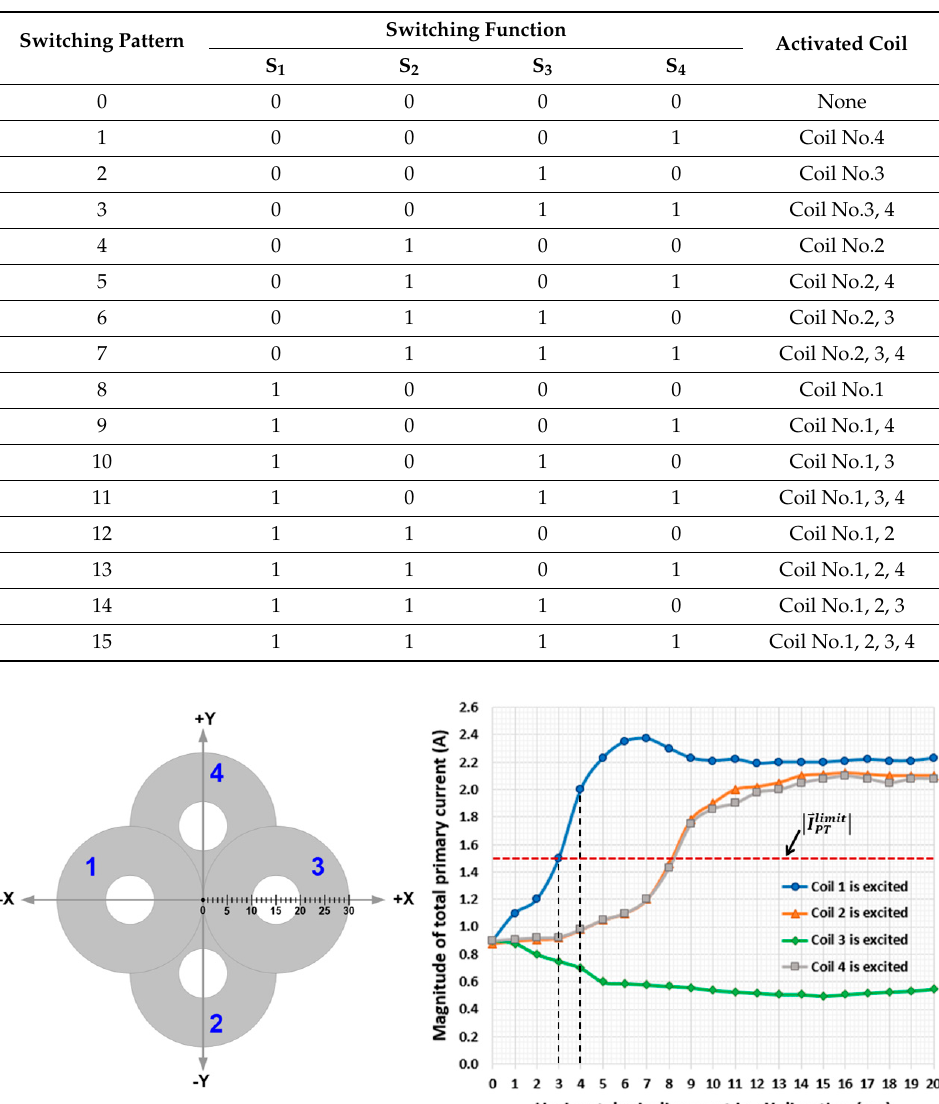
Table 1. Possible switching patterns of the inverter circuit with n = 4.